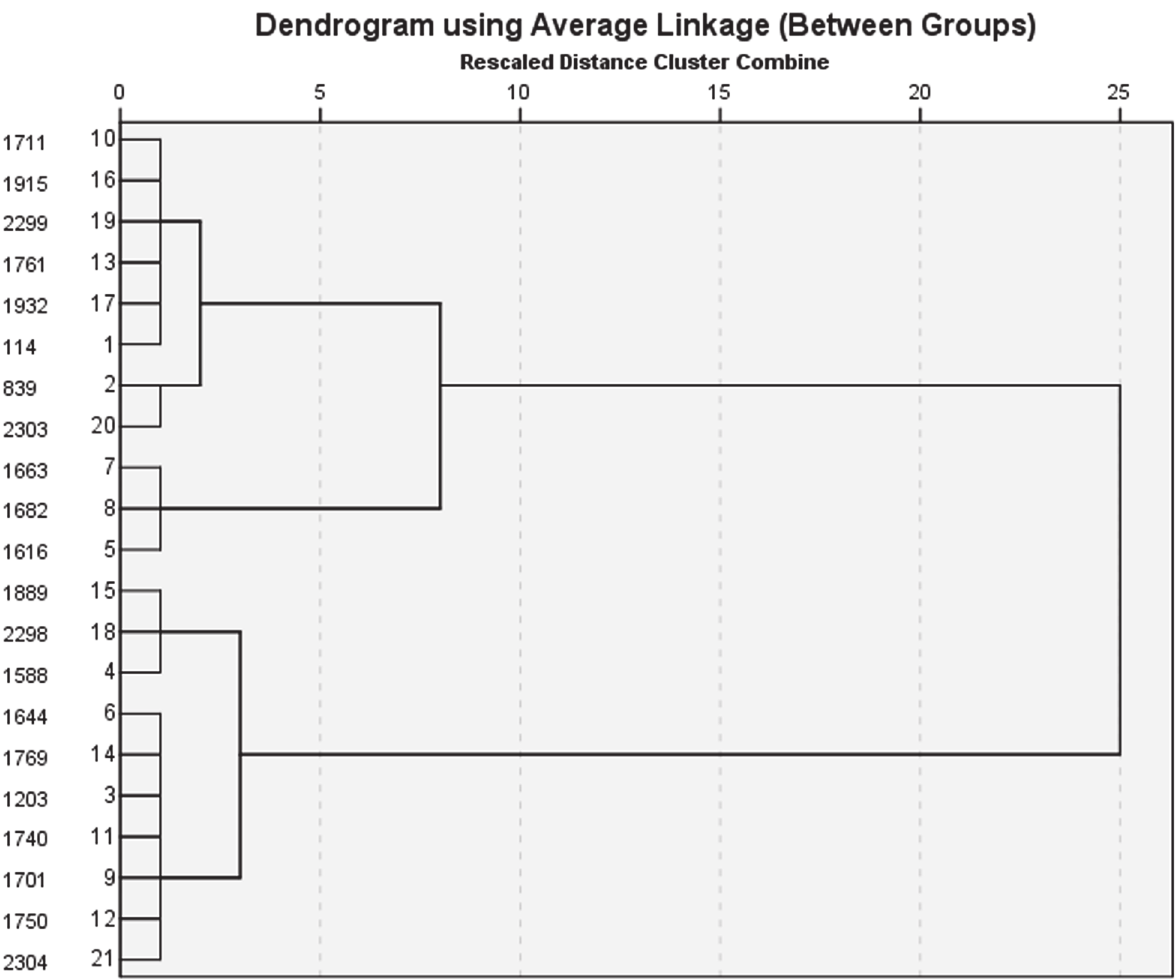
Fig 4. The dendrogram of the hierarchical clustering method for monitoring sites. The hierarchical clustering method was used to select the monitoring sites, and besides the five same sites shown in Table 3, another two sites: 1616 and 839 were selected.